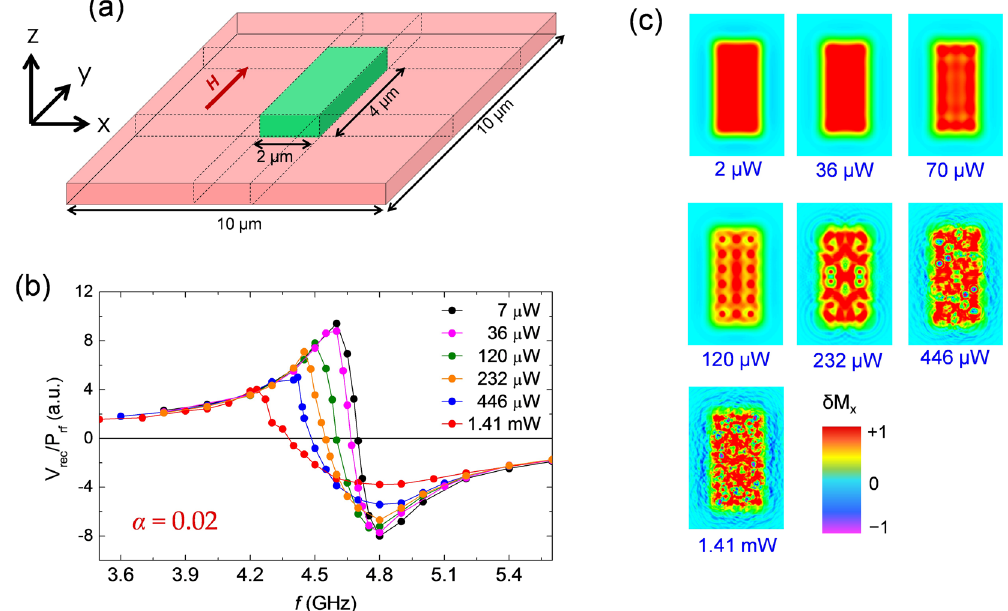
Figure 5. Micromagnetic simulation results. ( a ) Schematic diagram of the model sample for simulation. The dynamics were excited and the dynamic signals were extracted from the green area. Geometry of bias magnetic field is also shown. ( b ) Simulated V rec , rescaled by factor of 1/ P rf , are plotted as a function of f for different values of P rf . ( c ) Spatial maps of the dynamic magnetization for different values of P rf . Displayed area of each map is 4 × 6 µ m 2 taken from the central part of 10 × 10 µ m 2 model sample. Dynamics were excited in the central 2 × 4 µ m 2 area of the